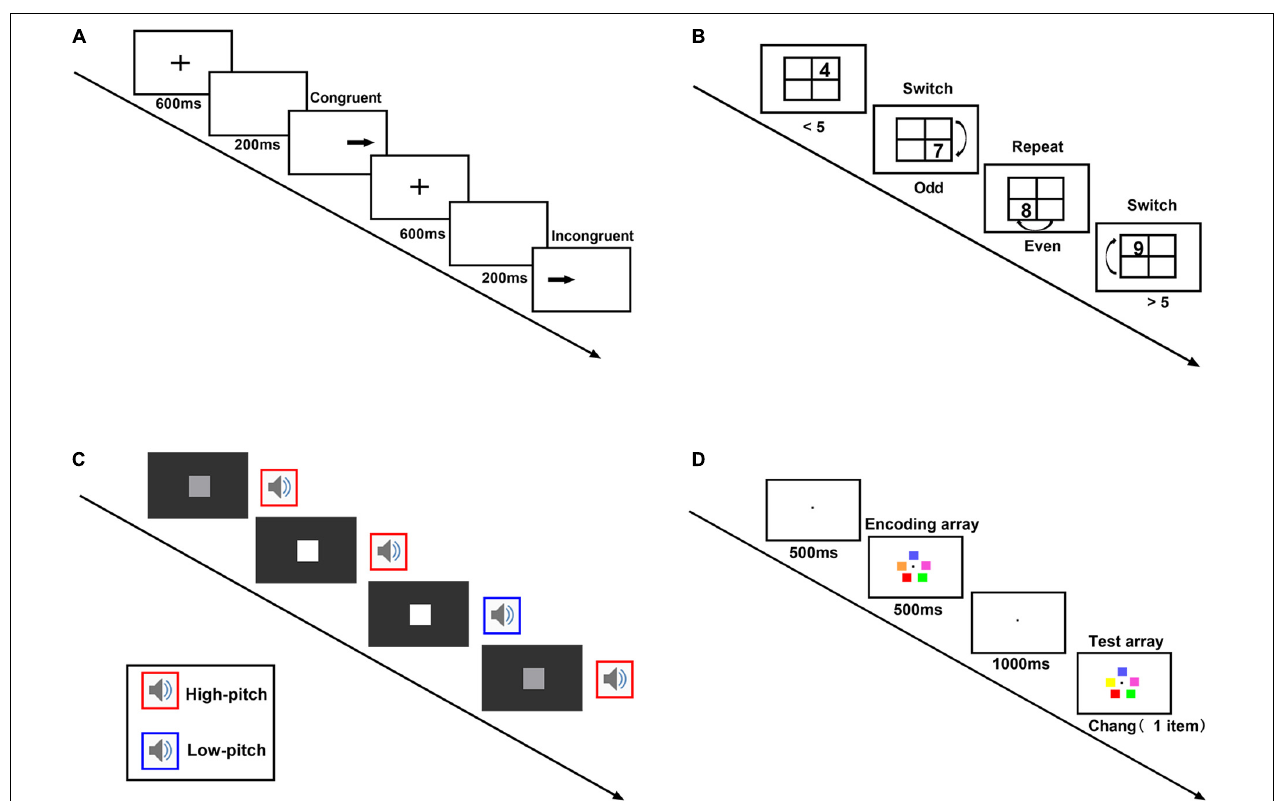
FIGURE 1 | The mini-computerized cognitive battery. (A) Spatial Stroop task. A typical trial starts with a fixation (600 ms). After a blank screen (200 ms), an arrow appears on the left or the right side of the screen. Participants needed to report the arrow direction by pressing corresponding keys as soon as possible with the accuracy ensured. (B) Task-switch task. On each trial, a number (randomly selected from 1, 2, 3, 4, 6, 7, 8, 9) appeared in a cell of a 2 × 2 grid. If the number appeared in the upper row, participants needed to respond whether it was greater or less than 5. If the number appeared in the lower row, they answered whether it was even or odd. The first number appeared in the right-top cell and changed location clock-wisely in the subsequent trials. (C) Divided attention task. A square appears at regular intervals on the screen, and at the same time, participants listen to a sound. Every trial appeared every 1 s and lasted 1 s each. Participants needed to detect changes in either the visual sequence or the audio sequence. Whenever the square gets noticeably lighter, or the sound gets noticeably higher pitch twice in a row, they need to press the space bar as soon as possible. (D) Working memory task. A typical trial starts with a fixation (500 ms), followed by an encoding array (5 colored squares). The colored squares appeared on an imaginary circle (500 ms). A test array appeared after a 1,000 ms delay. The test array could have 0, 1, 2, or 5 changed items with equal probability. Participants had to indicate whether the test array and the encoding array differed.